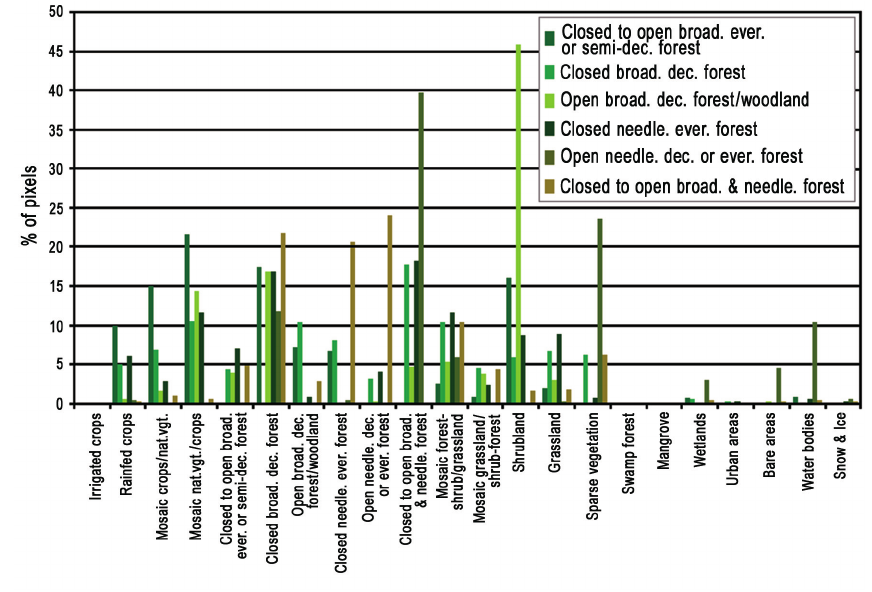
Fig. 4. Classification trajectories of the pixels belonging to a forest class in the GlobCover 2005 product, but which were not identically classified in the GlobCover 2009